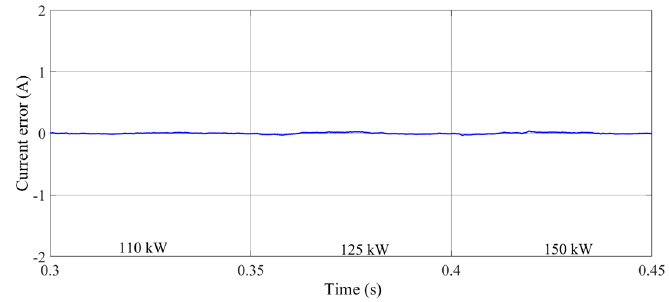
Energies 2019 , 12 , x FOR PEER REVIEW